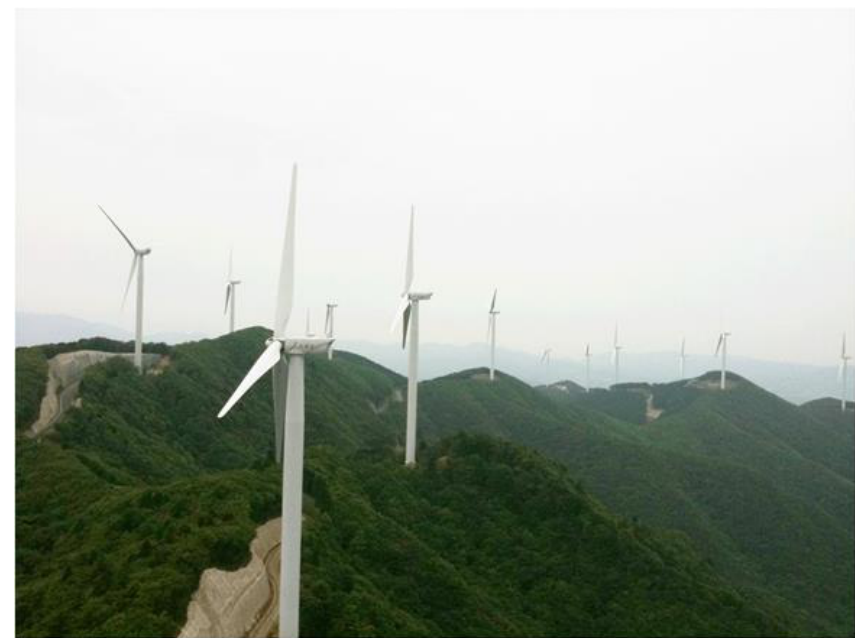
Figure 2. Location of Shiratakiyama Wind Farm in Yamaguchi Prefecture, Japan.